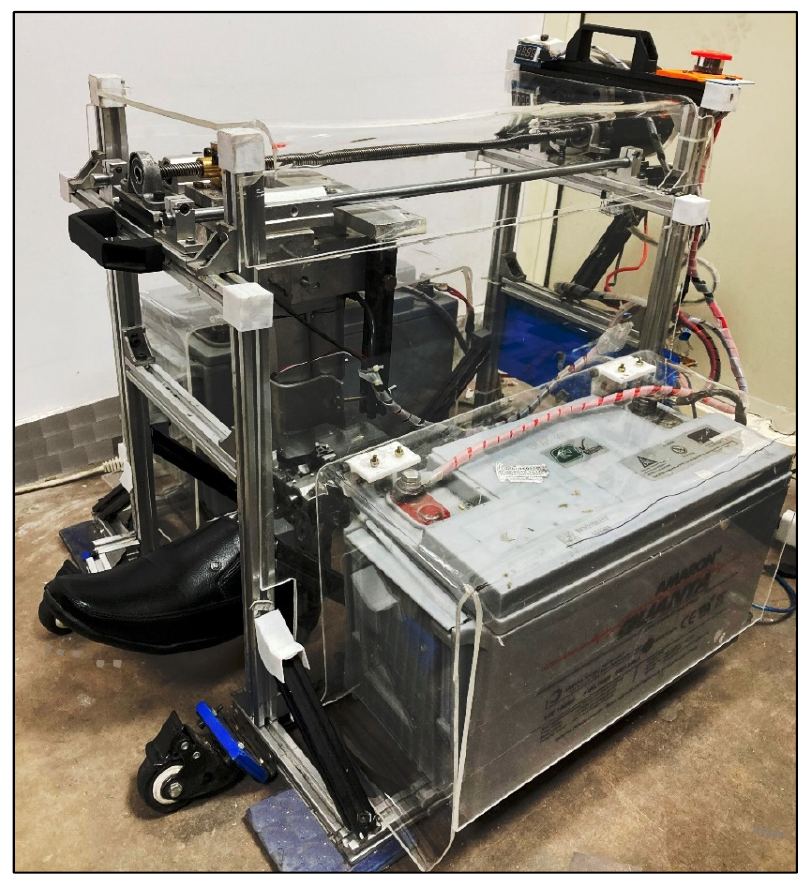
Figure 1. The developed portable slip testing device.